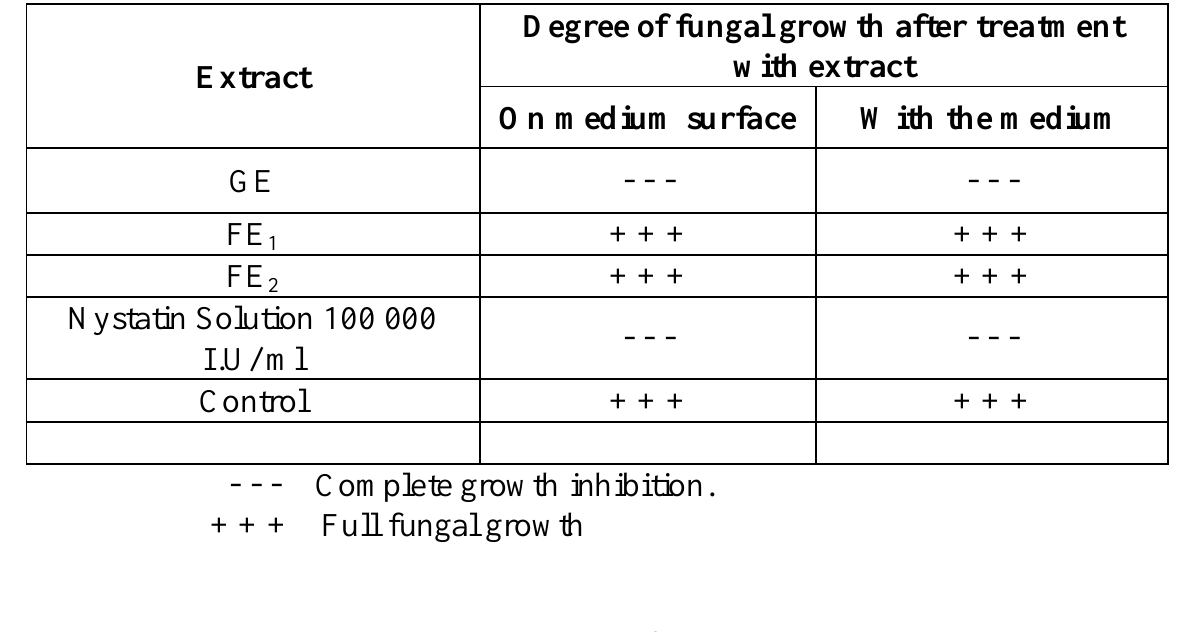
Table 2: Effect of GE & FE on, A. fumigatus inoculated in poultry feed Day after